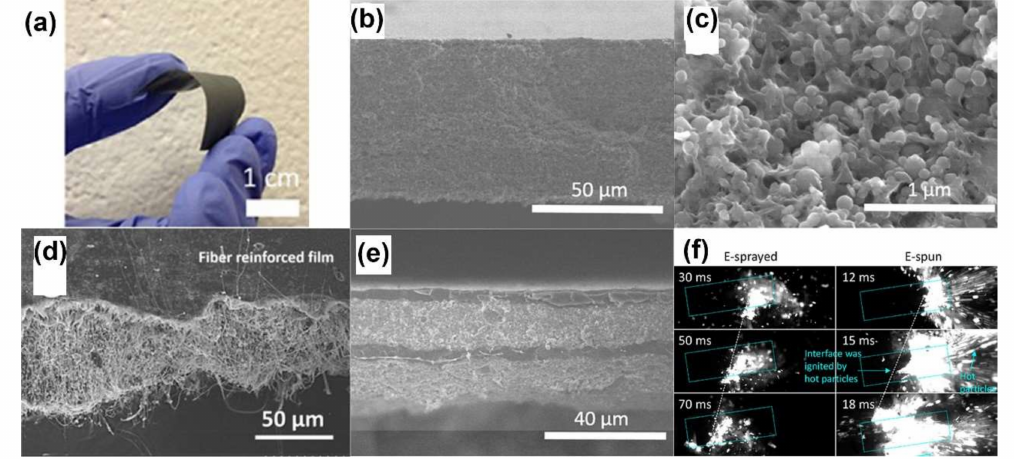
Figure 5. ( a ) Free-standing Al/PVDF film with 50 wt% nanoaluminum loading. Adapted with